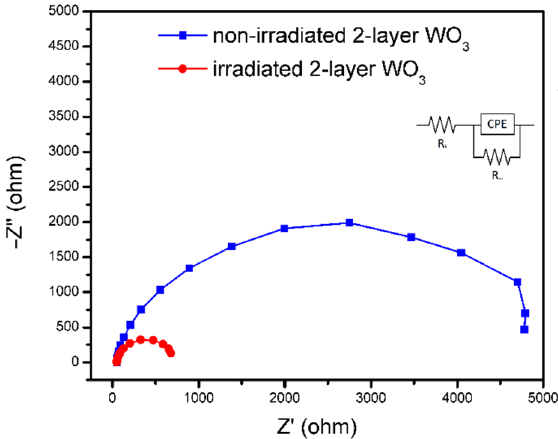
Figure 5. EIS Nyquist plots of non-irradiated and irradiated double-layer WO 3 .